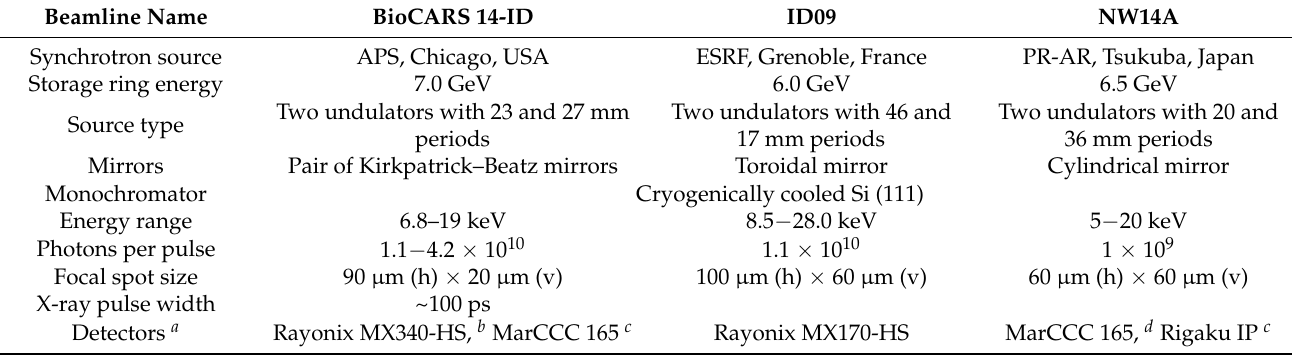
Table 1. Short characteristics of synchrotron beamlines facilitating TR Laue photocrystallography experiments. Note the most up-to-date parameters may somewhat differ because of continuous development of these beamlines and storage ring